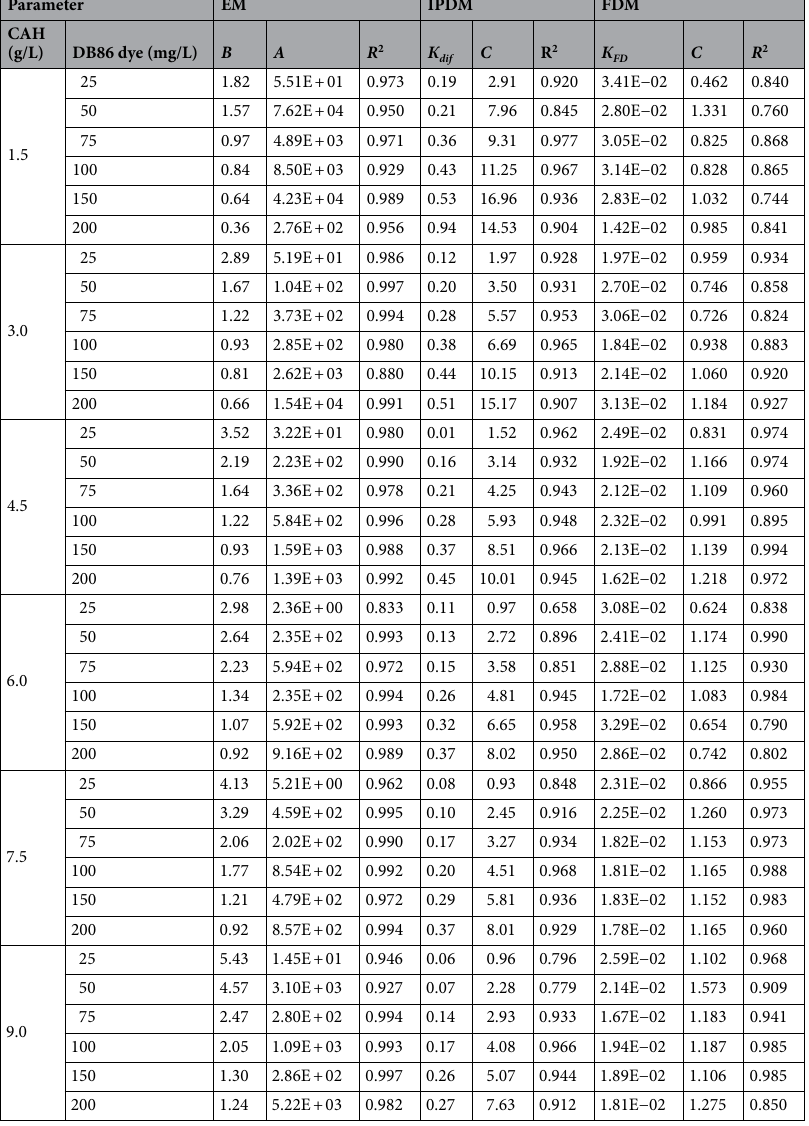
Table 4. EM, IPDM and FDM results of DB86 dye absorption [ C 0 (25–200 mg/L) by CAH doses (1.5–9.0 g/L), and Temp. (25 ± 2